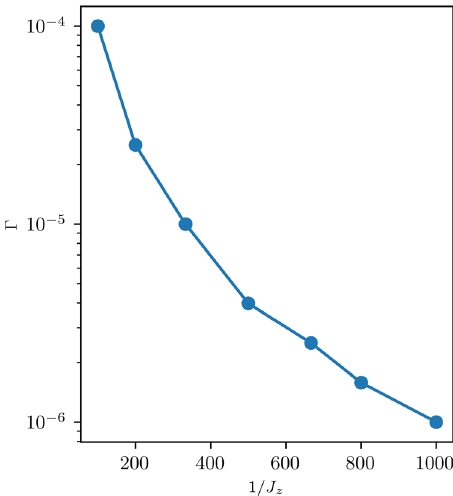
Fig. 3 Decay rates of the π mode extracted from exact diagonalization (ED). The decay rate from the ED data in Fig. 2 plotted on a logarithmic scale vs 1/ J z where J z is the interaction strength. The constant slope for 1000 ≥ 1/ J z ≥ 500 indicates that for 1/ J z ≫ 1, the decay rate is Γ (cid:3) e (cid:2) c = J z , where J z is in units of J x and c is a O (1)